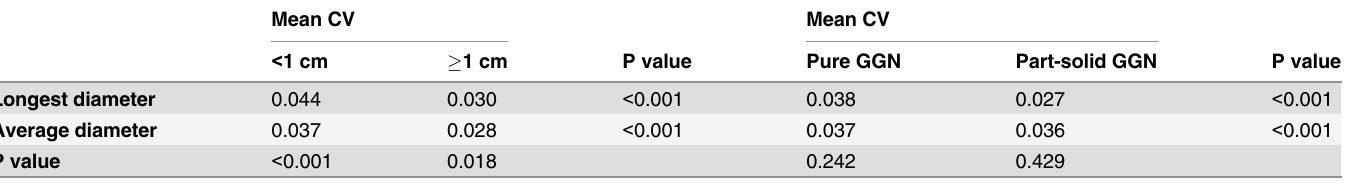
Table 4. Subgroup analysis according to nodule size and type in situation 1 (same reader follow-up).